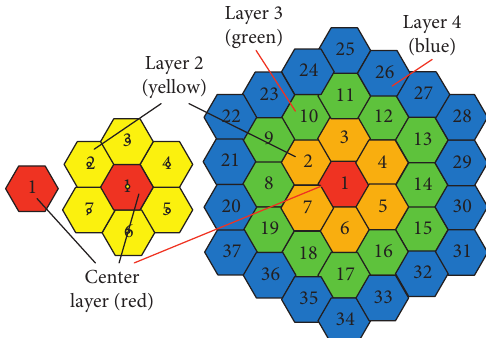
Figure 1: Ultrasound vibration network based on honeycomb